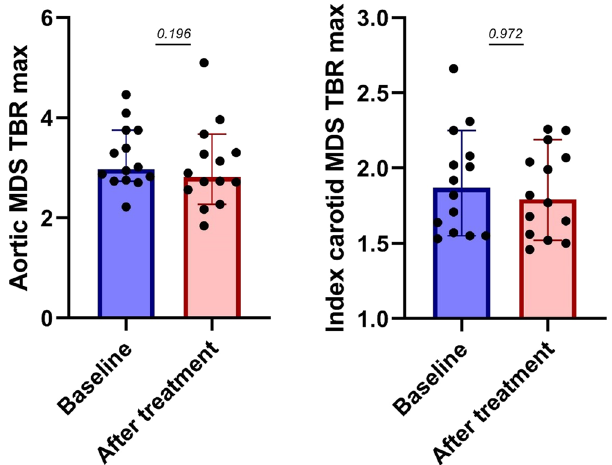
Figure 1. Statin treatment does not abolish arterial wall inflammation in CKD subjects. Baseline and after statin treatment arterial wall inflammation measured as mean of maximum uptake of most diseased segment target to background ratio (MDS TBR) in the aorta (left) and index carotid (right).